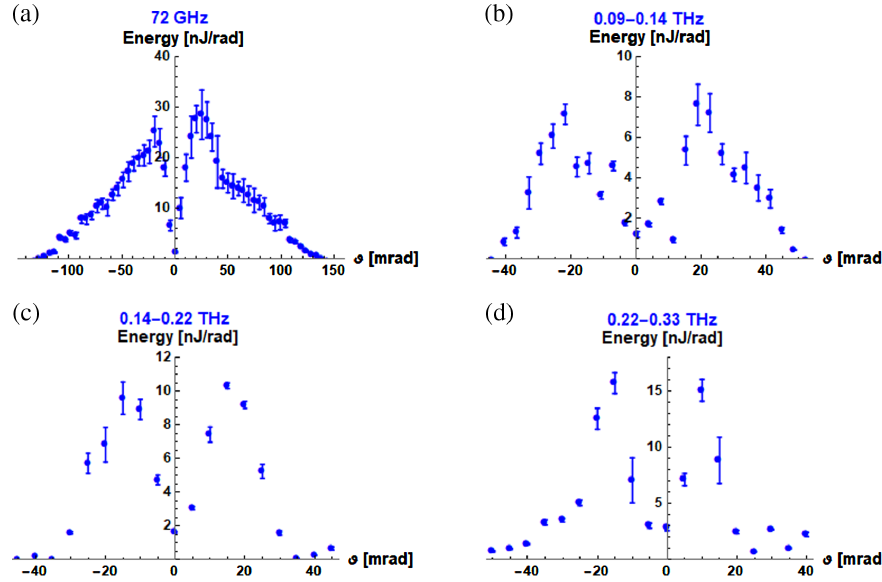
FIG. 3. Profiles of far-field CTR (p-polarization) measured at different frequencies: 72 GHz (a), 90 – 140 GHz (b), 0.14 – 0.22 THz (c),